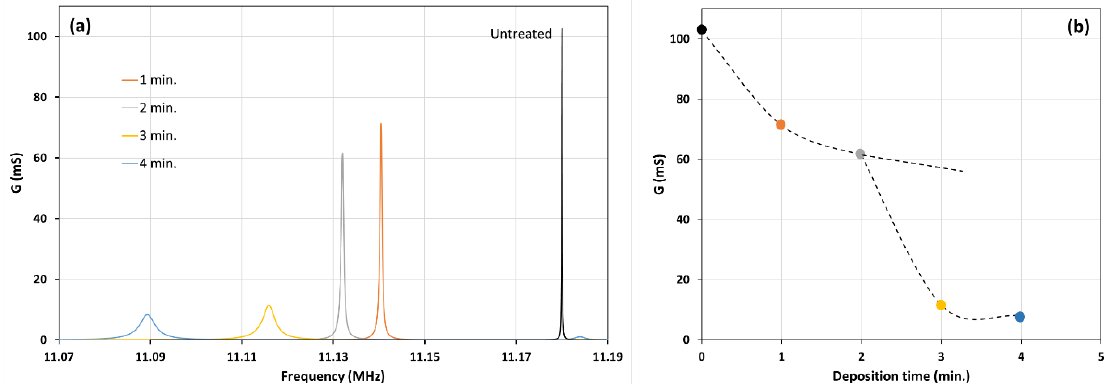
Figure 7. ( a ) The effect of deposition time on the resonance frequency and the conductance. ( b ) The change of the conductance due to the various deposition times.